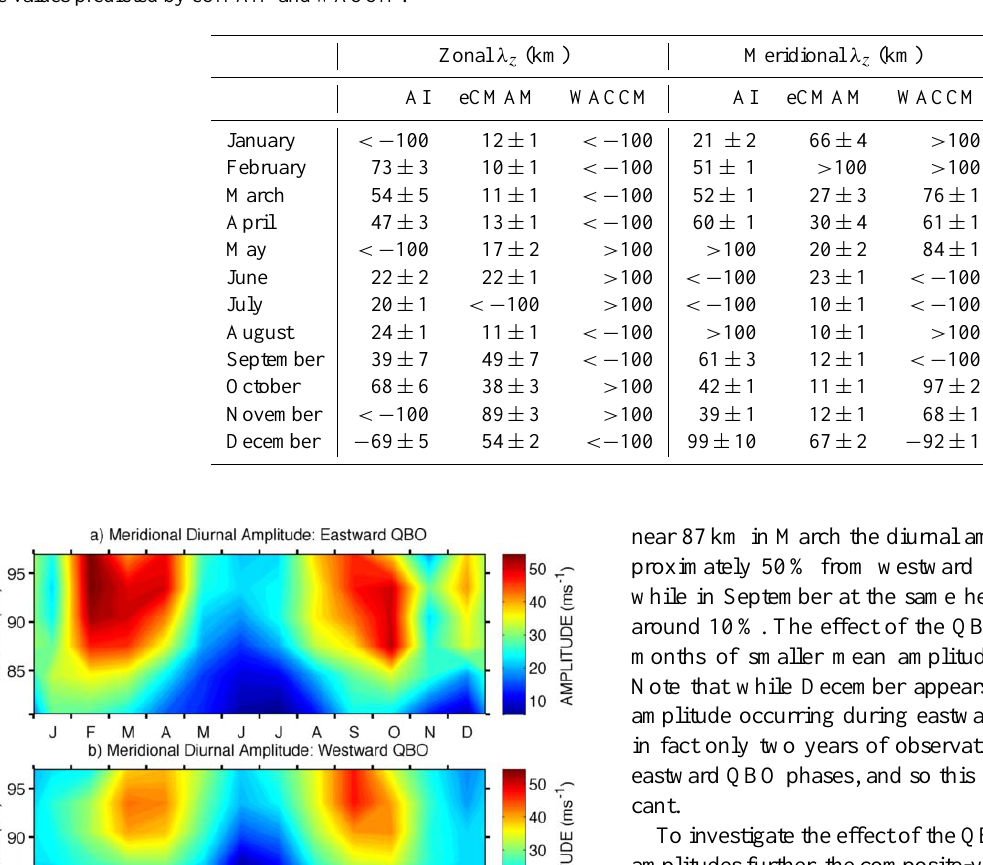
Table 2. Table of the mean semidiurnal tide vertical wavelengths (km) as observed by the Ascension Island radar (AI) for each month, and the values predicted by eCMAM and WACCM.